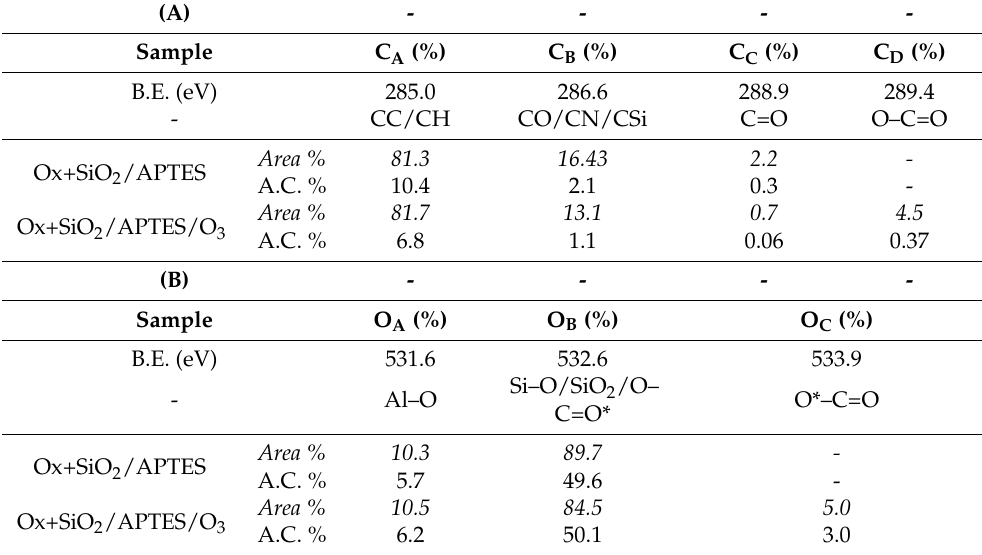
Table 2. Binding energy (B.E.) of the different links, area percentages ( cursive ) and A.C. % after